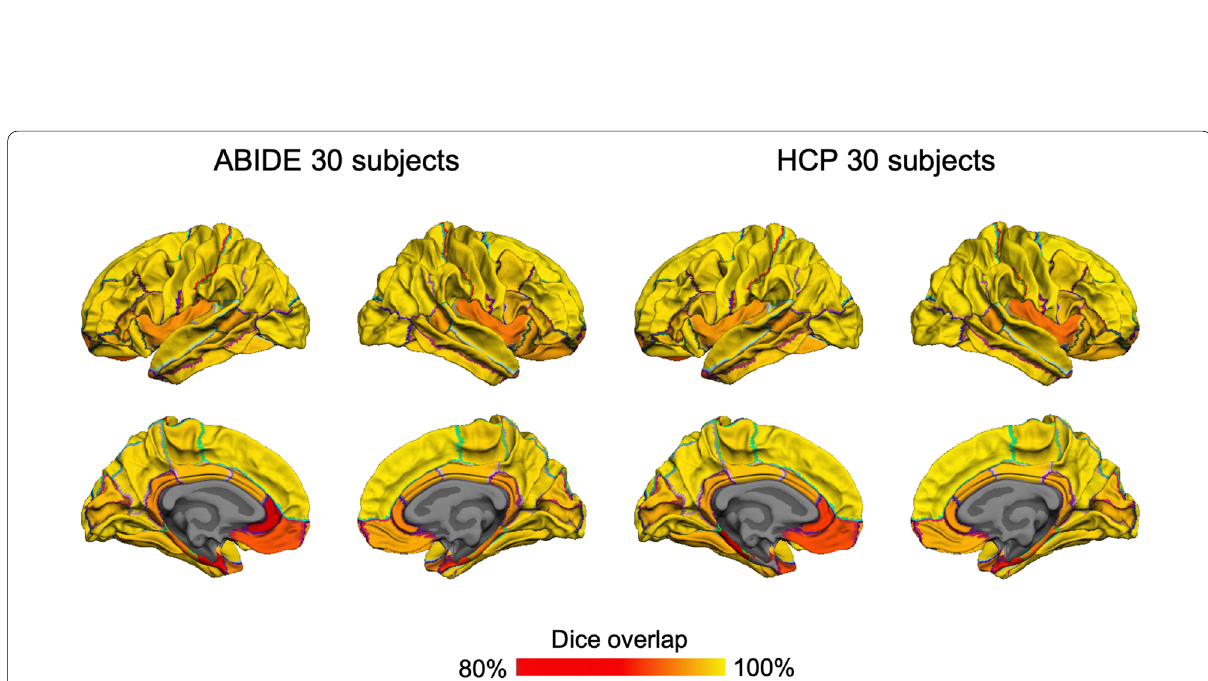
Fig. 7 Anatomical parcellation in the ASD and HCP datasets. We assessed the similarity in anatomical cortical parcellation, measured by the Dice coefficient, for each cortical region obtained with FastCSR compared to FreeSurfer in both the ABIDE-II (left) and HCP (right) datasets. The Dice coefficients for most cortical areas (77.94% in ABIDE and 76.47% in HCP) are above 95%. Cortical areas with Dice coefficients smaller than 90% included the entorhinal region and the left rostral anterior cingulate cortex in both datasets, and the in the HCP dataset, additionally included the left parahippocampal